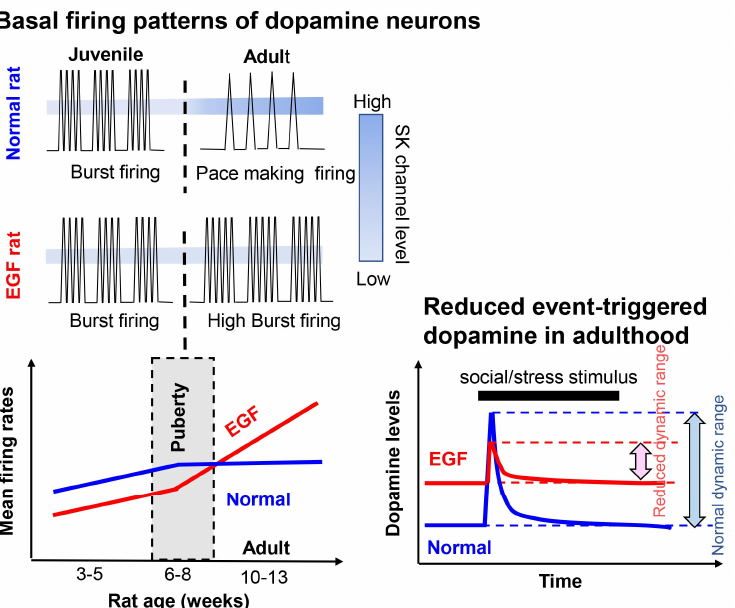
Figure 3. Age-dependent alteration of firing activity of dopamine neurons. Baseline burst firing is reduced in the post-pubertal stage in parallel with the increase in SK channel expression in normal development. In contrast to the profile of normal animals, baseline burst firing is elevated and the expression of SK channels is reduced in the EGF model at their post-pubertal stage [117]. Accordingly, event-triggered and stress-evoked fractions of dopamine (DA) release are relatively suppressed with the given high baseline release and might be implicated in their stress vulnerability.